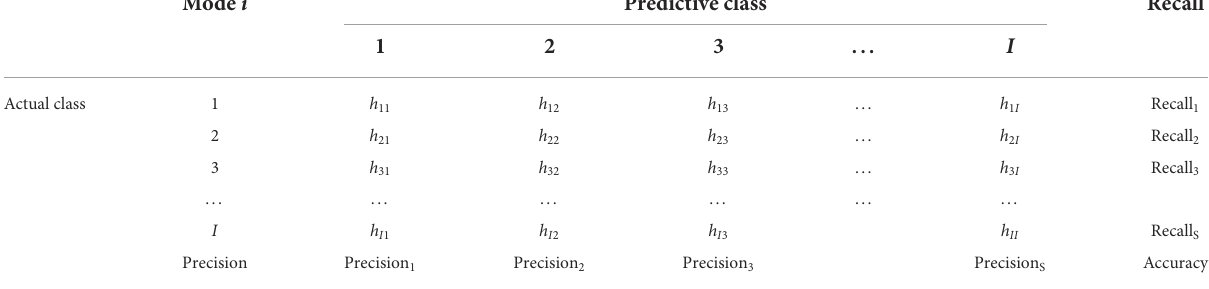
TABLE 6 Multi-classification confusion matrix.